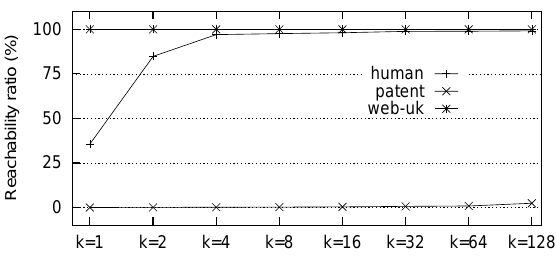
Figure 1. Reachability ratio ( RR ) of p2HL s based on k nodes with a large